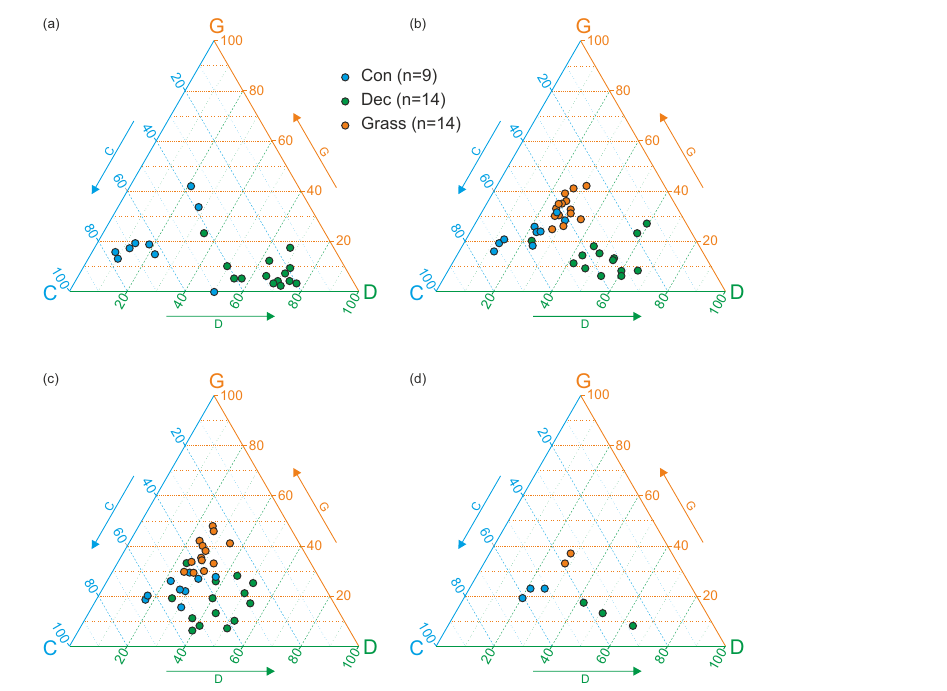
Figure 7. Ternary plots for the CDG indices: (a) litter, (b) Ah1 and (c) Ah2, as well as (d) means for vegetation types. Each point represents the mean of litter, Ah1 and Ah2, with regard to con, dec and